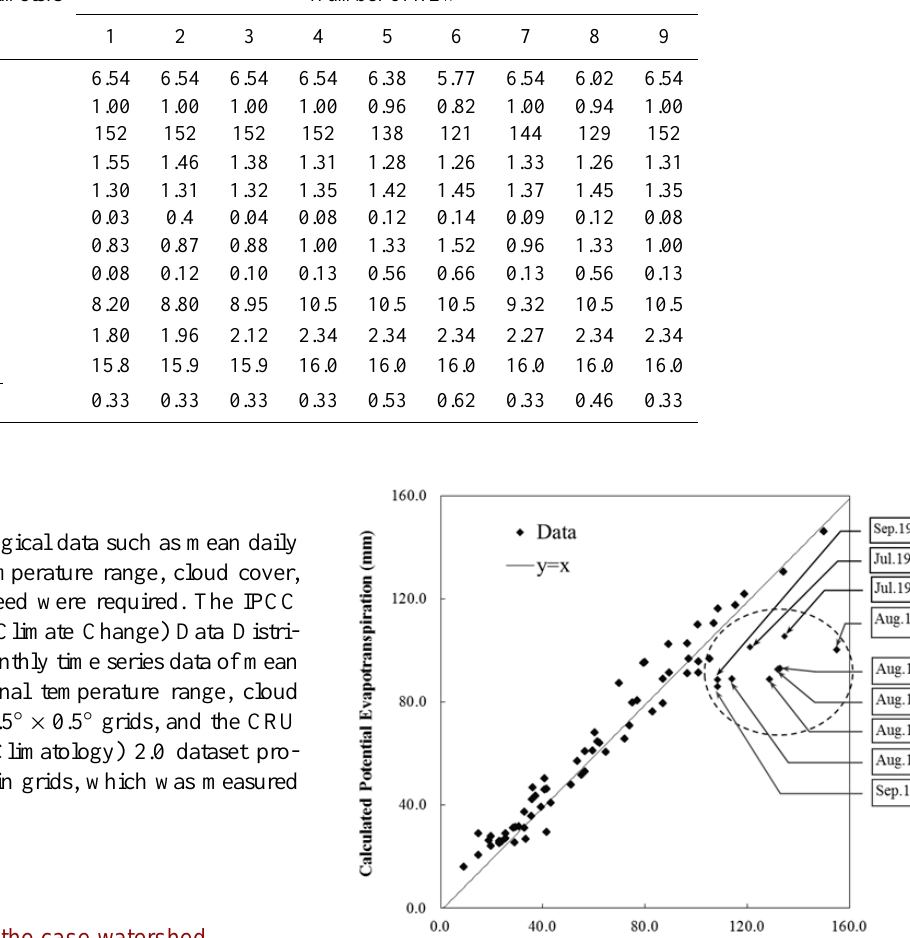
Table 1. Results of daily runoff simulation using the REW approach. Parameters Number of REW